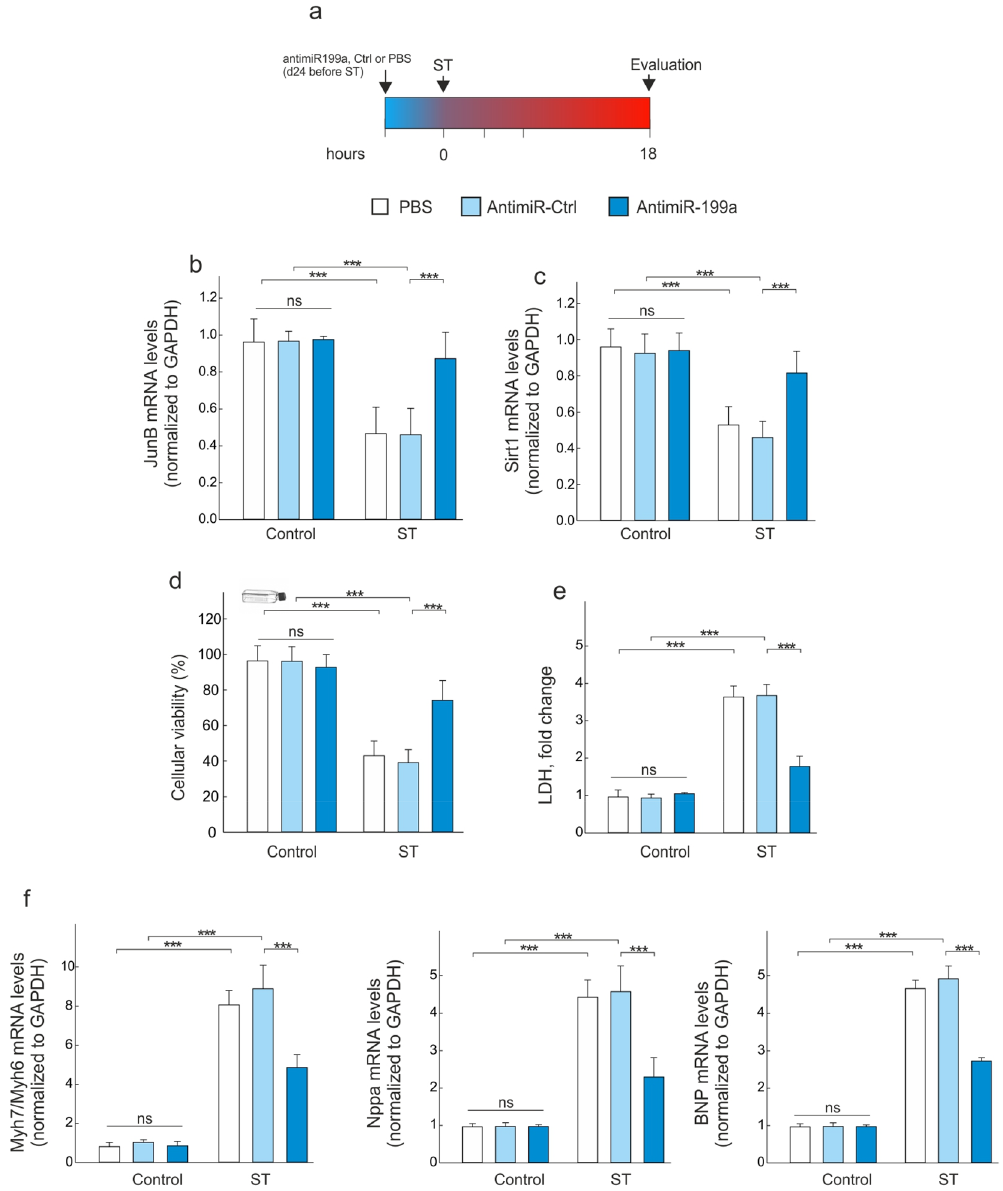
Figure 6. AntimiR-199a treatment prevents cardiac hypertrophy. ( a ) Design of the study using CMs under stretching. ( b ) Quantification of JunB mRNA levels in CMs after cyclic stretching assessed. ( c ) Quantification of Sirt1 mRNA levels by RT-qPCR in CMs after cyclic stretching. ( d ) Cell viability measured by MTT assay of CMs treated with PBS, antimiR-Ctrl or antimiR-199a. ( e ) LDH levels in CMs treated with PBS, antimiR-Ctrl or antimiR-199a after cyclic stretching. ( f ) Quantitative real-time PCR analysis of molecular markers for cardiac myocyte hypertrophy (Myh7/Myh6, Nppa and BNP). All quantifications derive from n = 10 independent assays/ group. All quantitative data are reported as means ± SEM. ***P < 0.001 determined by two-way ANOVA followed by Bonferroni’s post hoc test. BNP: brain natriuretic peptide; LDH: lactate dehydrogenase; ST: stretching; other abbreviations as in Fig.